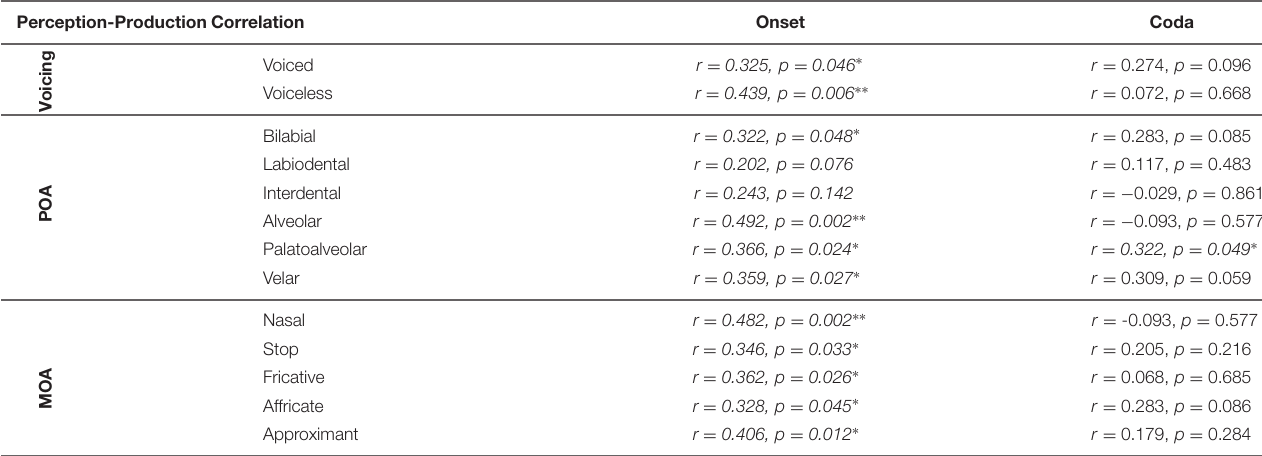
TABLE 2 | Pearson’s correlation analysis results for the perception and production scores in the onset and coda positions from all 38 Chinese subjects, respectively, for the voicing, place of Articulation (POA), and manner of articulation (MOA) subcategories. Perception-Production Correlation